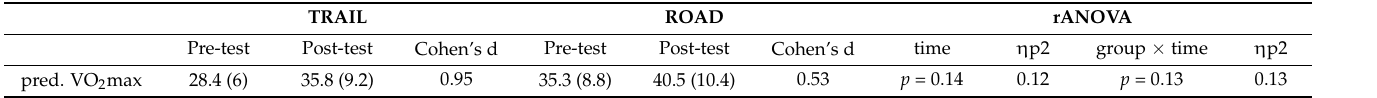
Table 7. Effect on VO 2 max of an 8-week trail and road running training